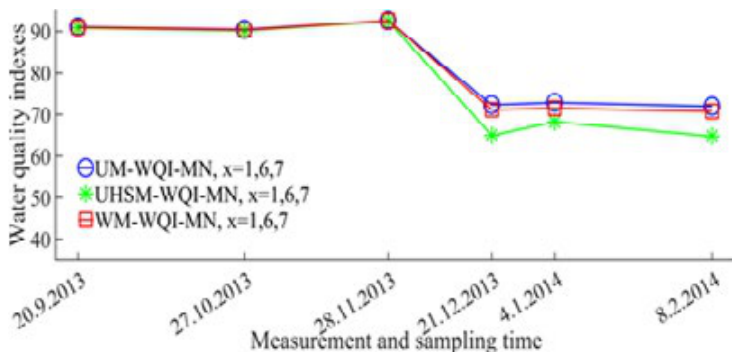
Fig. 7: Change of water quality indices with three parameters with respect to time for station KM)